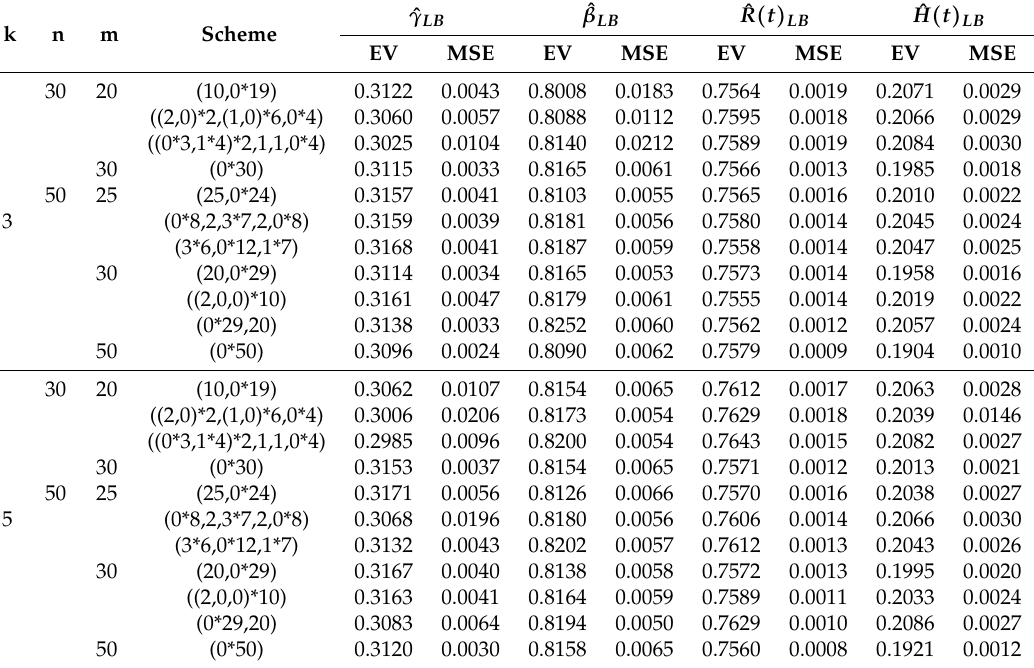
Table 5. Lindley approximation values and MSEs of parameters and reliability and hazard functions under LLF when h = − 0.5, γ = 0.3, β = 0.8, t = 1.5, a 1 = 1.08, b 1 = 3.6, a 2 = 16, b 2 =